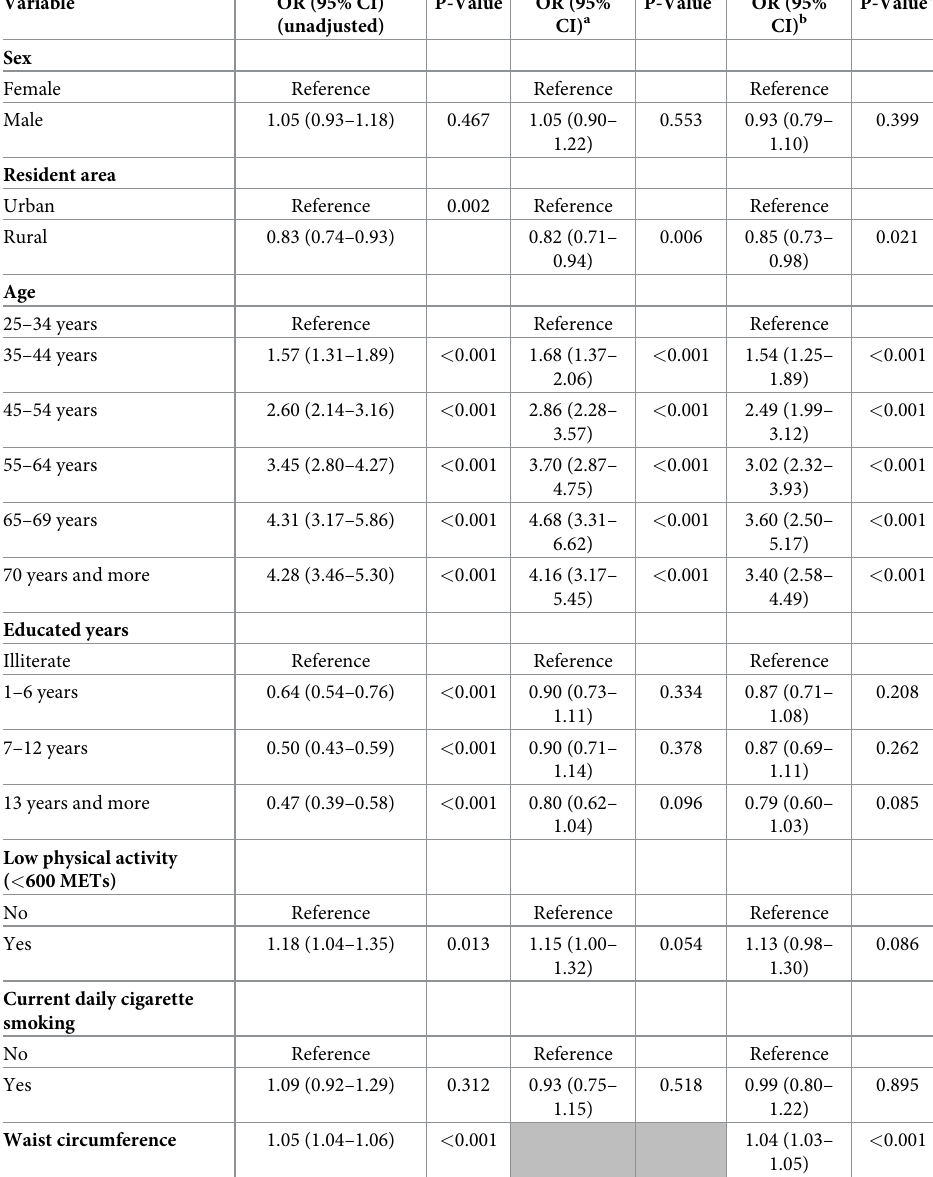
Table 3. Logistic regression model showing risk factors of metabolically unhealthy phenotype among normal weight individuals. Variable